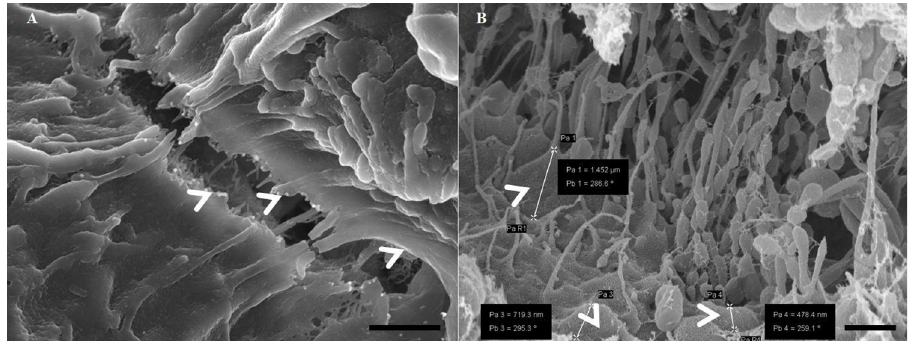
Fig 9. A HR-SEM micrograph representing multiple layers of PM interaction within the PC spaces of BECs. (A) An image of a carbon-coated PM interaction; (B) An image of Au:Pd coated PM interaction as seen by the “white arrowheads.” Scale bar = 1000